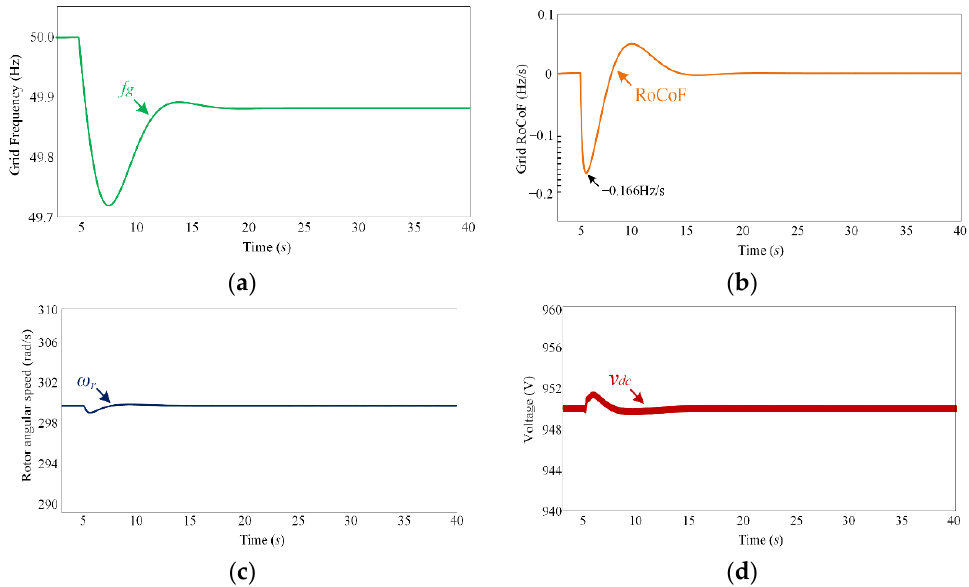
Figure 14. Simulation results when the DFIG system provides inertia support and the speed recov- ery control bandwidth is 0.1 Hz. ( a ) Grid frequency; ( b ) grid RoCoF; ( c ) rotor angular speed. ( d ) DC-link voltage.